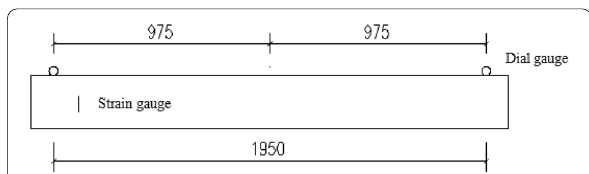
Fig. 4 Arrangement of measure point of test beams.